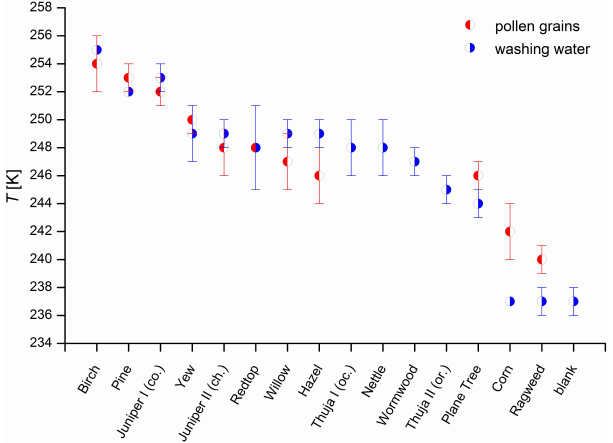
Fig. 1. Median freezing temperatures of different pollen samples: whole pollen grains and washing waters. The error bars mark the standard deviation rounded to integer numbers in Kelvin. If the calculated error is smaller than 0.5K, no error bars are given.